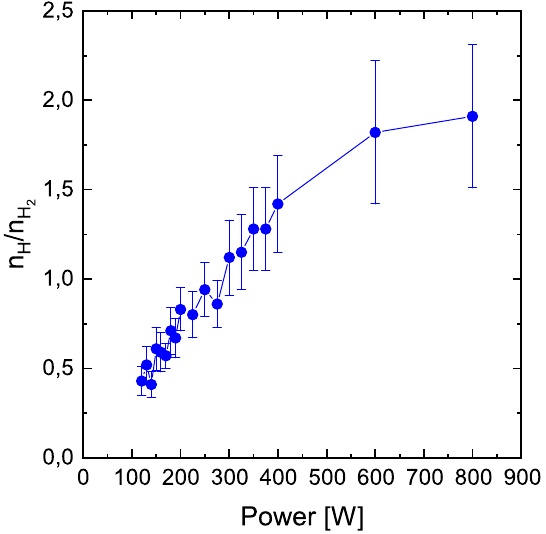
FIG. 7. Density ratio of atomic to molecular hydrogen obtained from the OES evaluations for varying power.